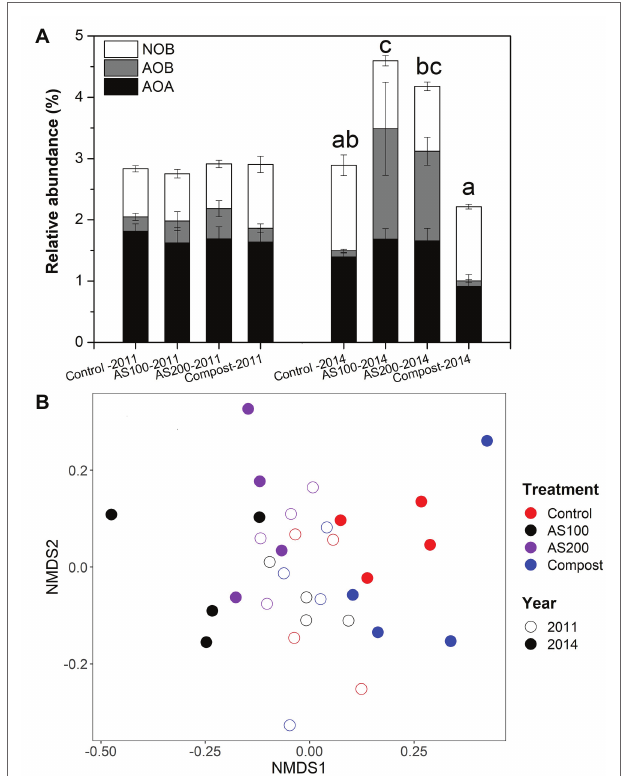
FIGURE 2 | (A) Relative abundance of nitrifying populations based on differences in 16S rRNA genes for four N treatments. Error bars represent standard errors ( n = 4). Different letters above the bars indicate a significant different in total nitrifying populations in 2014. Abbreviation: AOA, ammonia oxidizing archaea; AOB, ammonia oxidizing bacteria; NOB, nitrite oxidizing bacteria. (B) Nonmetric multidimensional scaling (NMDS) ordination based on the abundance of 16S rRNA gene operational taxonomic units (OTUs) of all nitrifying populations. Colors denote treatment (red = control, black = AS100, purple = AS200, blue = compost). Fill denotes sampling time (open = 2011, solid =